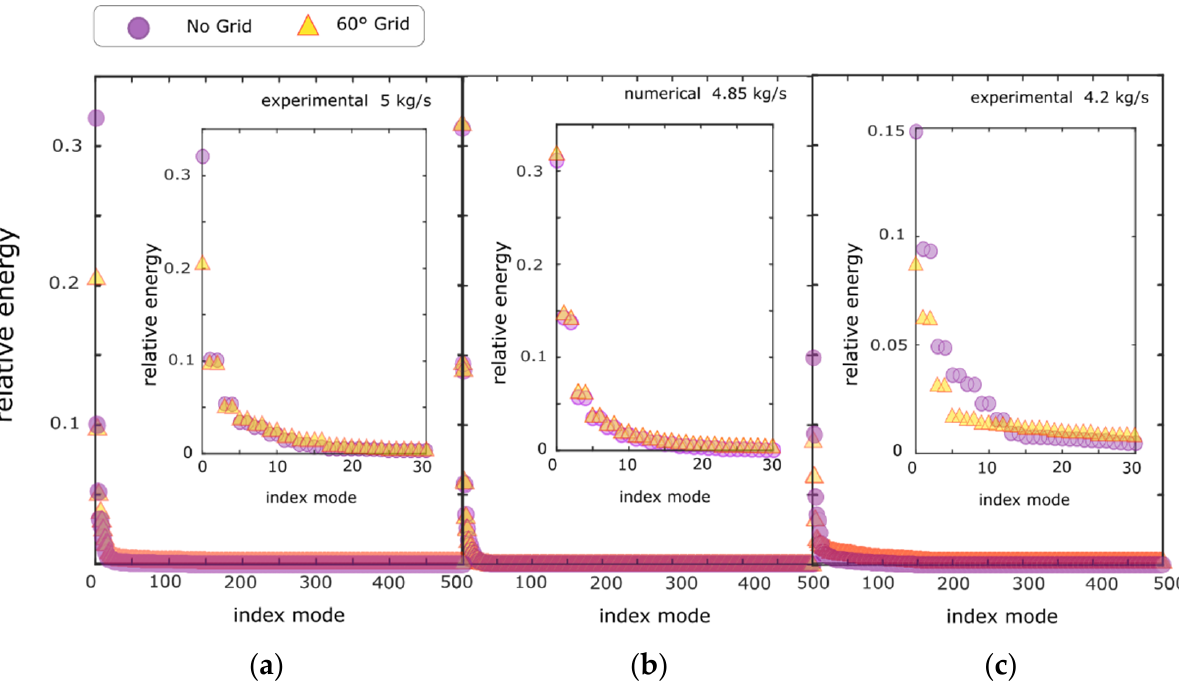
Figure 7. Relative energy in the modes calculated from SVD. Experimental signals. ( a ) 5 kg/s; ( c ) 4.2 kg/s; numerical signal ( b ) 4.85 kg/s.